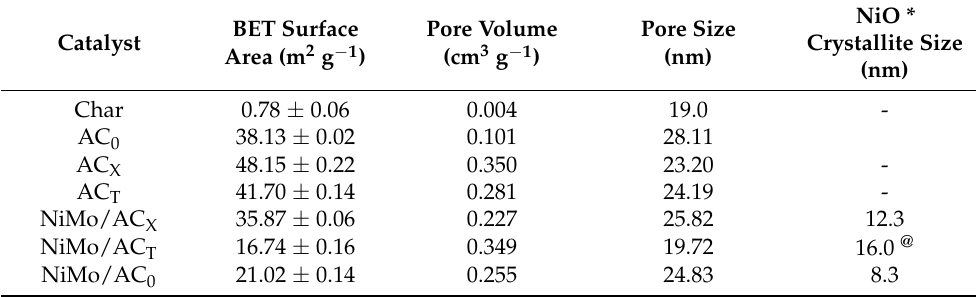
Figure 3. N 2 adsorption–desorption isotherms of prepared NiMo/AC catalysts: ( A ) NiMo/AC X , ( B ) NiMo/AC 0 and ( C ) NiMo/AC T . Table 3. Surface characteristics of corn cob-activated chars and NiMo/AC catalysts.